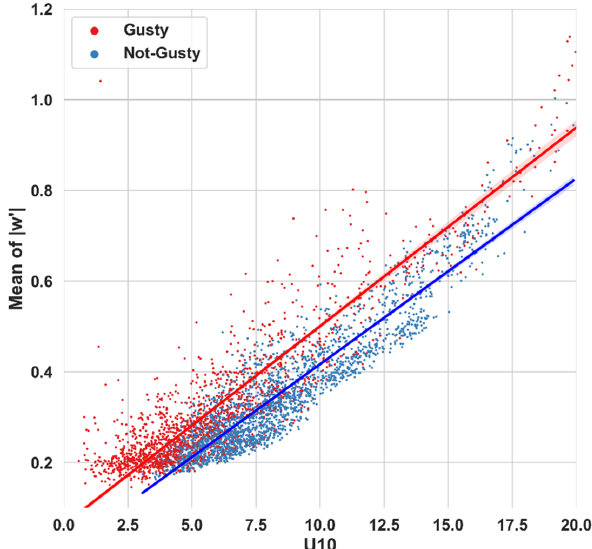
Figure 9. Mean of |𝑤′| as a function of 𝑈 (cid:2869)(cid:2868) , red points are the gusty winds ( 𝐺 (cid:2885) (cid:3408) 0.165) , blue points are the not-gusty winds ( 𝐺 (cid:2885) < 0.165) . The red and blue line are best fit linear regressions with shaded area marking the 95% confidence